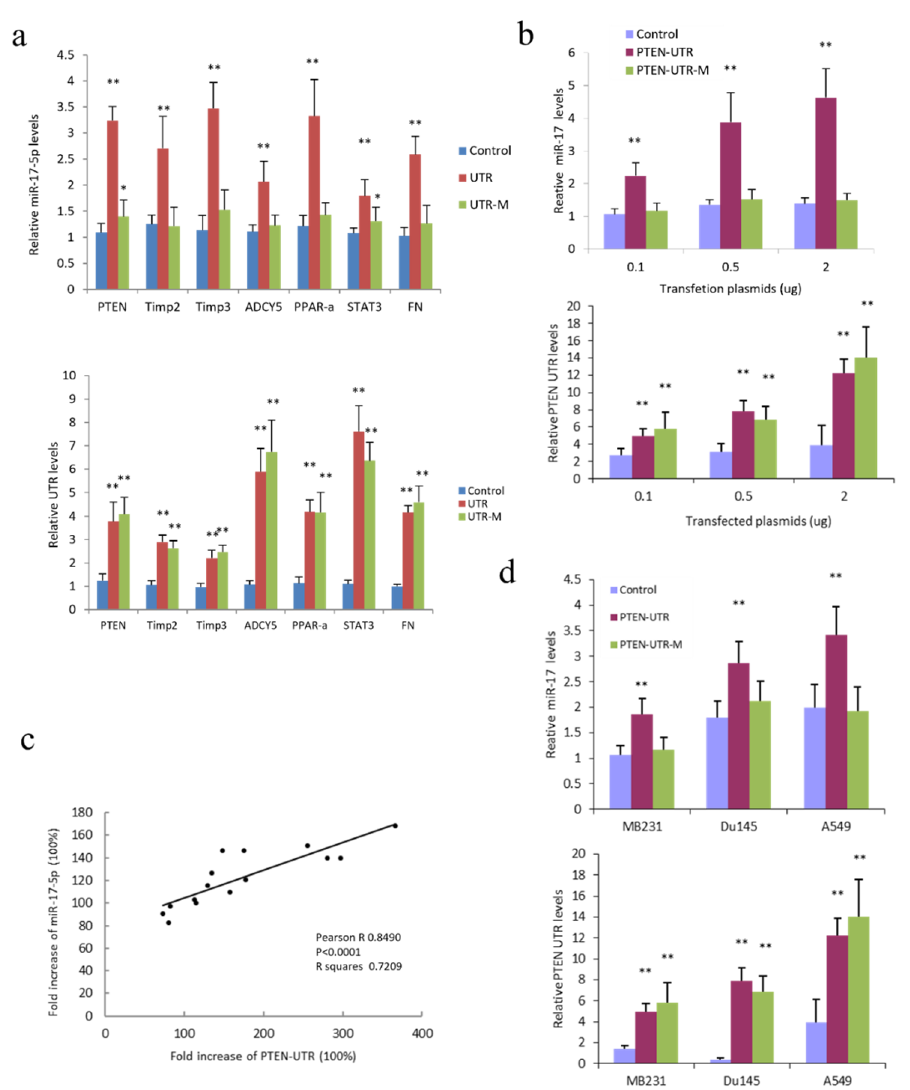
Figure 3. Increased expression of miR-17-5p target gene 3 (cid:48) -UTR increased miR-17-5p levels ( a ) Upper, HepG2 cells were co-transfected with miR-17-5p and a control vector, 3 (cid:48) -UTR or 3 (cid:48) -UTR with mutated miR-17-5p binding sites (UTR-M) of PTEN, Timp2, Timp3, ADCY5, PPAR- α , STAT3, and FN. 3 (cid:48) - UTR transfected cells showed increased miR-17-5p levels, but the UTR-M transfected cells showed comparable miR-17-5p levels to control. Lower, PCR showed the expression of 3 (cid:48) -UTR of the above genes in the transfected cells. * p < 0.05, ** p < 0.01 vs. control; Error bars, SD; n = 5. ( b ) Upper, HepG2 cells were co-transfected with miR-17-5p (1 µ g/mL) and a control vector, PTEN-UTR or PTEN-UTR-M. Expression of PTEN-UTR, but not PTEN-UTR-M increased miR-17-5p levels, which was dose-related. Lower, the expression of PTEN 3 (cid:48) -UTR in the transfected cells. ** p < 0.01 vs. control; Error bars, SD; n = 5. ( c ) Pearson correlation between fold increase of PTEN UTR and miR-17-5p in the PTEN UTR and miR-17-5p co-transfected HepG2 cells was analyzed by Prism 8. Fold increases in PTEN 3 (cid:48) -UTR were positively correlated with miR-17-5p. Pearson R = 0.8490; p < 0.0001; n = 15. ( d ) Upper, miR-17-5p was co-transfected with control vector, PTEN-UTR or PTEN-UTR-M in breast cancer (MDA-MB-231), prostate cancer (DU145), and lung cancer cell lines (A549). The expression of PTEN-UTR increased miR-17-5p levels in all cell lines. Lower, expression of PTEN 3 (cid:48) -UTR in the transfected cell lines. ** p < 0.01 vs. control; Error bars, SD; n =